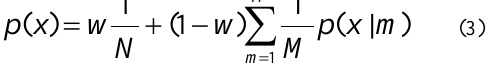
Figure 1. Phase-based LSR extraction. (a) Original image. (b) Edge phase. (c) Phase-based grouping. (d) LSR and